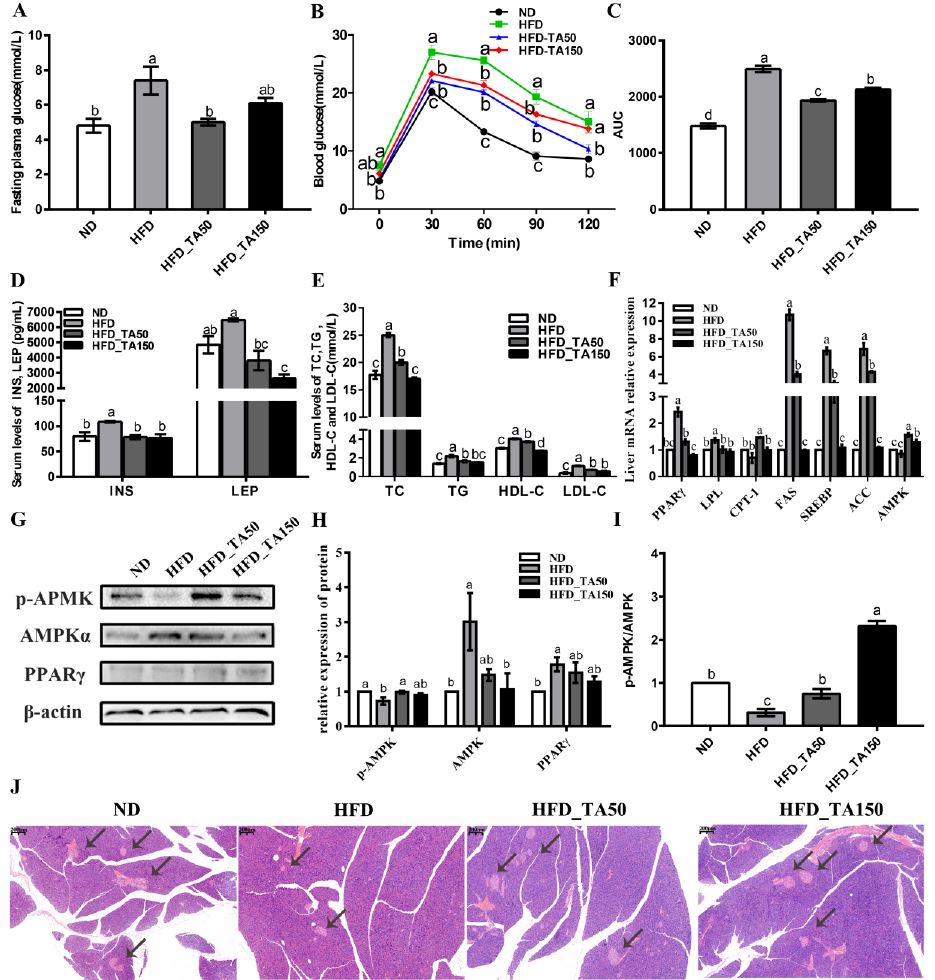
Figure 2. Effect of dietary tannic acid on the glucolipid metabolism in mice induced by a high-fat diet. ( A ) Fasting plasma glucose, ( B ) blood glucose, ( C ) area under curve of OGTT, ( D ) serum INS and LEP, ( E ) serum levels of TC, TG, HDL-c and LDL-c, ( F ) relative expression of mRNA levels in the liver, ( G ) Western blot of hepatic AMPKα, p -AMPK and PPARγ, ( H ) relative expression of hepatic AMPKα, p - AMPK and PPARγ, ( I ) p -AMKP/AMPK, ( J ) H&E staining of pancreatic tissues. Black arrows indicate the pancreas islets. INS: insulin, LEP: leptin, TC: serum cholesterol, TG: serum triglyceride, HDL-c: high-density-lipoprotein cholesterol, LDL-c: low-density-lipoprotein cholesterol. Data are expressed as the mean ± SEM. Different letters between any two groups indicated that there was significant difference between the two groups ( p < 0.05).